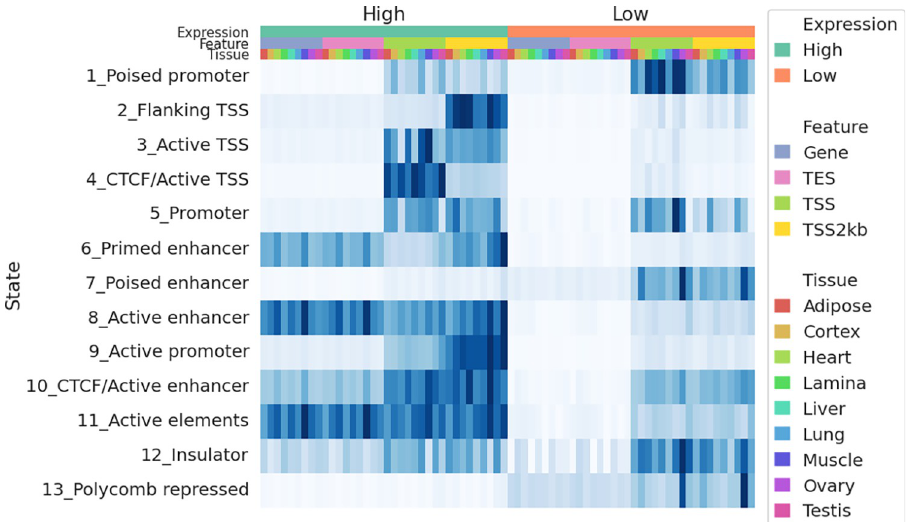
Fig 7. State enrichment in tissue specific genes. Heatmap of enrichment for each state around genes expressed and not expressed in each tissue. The top three color bars denote gene expression status, genic features, and tissues, respectively. Enrichment scores were normalized in each